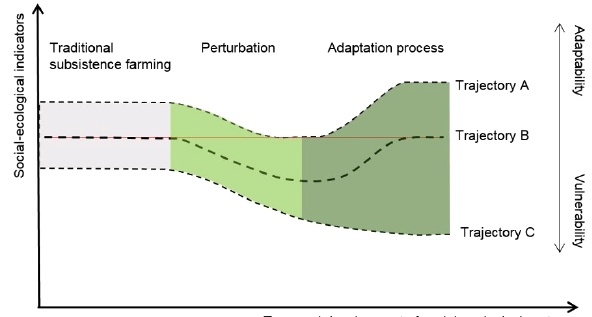
Fig. 5 . Potential system trajectories that may also apply to the landscape of Banaue. In trajectory A, the system recovers from the perturbation and is able to take advantage of new opportunities, therefore demonstrating adaptability. Trajectory B shows a robust system that conserves the same level of ecosystem services and benefits after recovery from the perturbation. Trajectory C shows vulnerability of the system to perturbation and the incapacity of the system to fully recover from the disturbance, but without necessarily experiencing a shift of the fundamental social-ecological system structures, processes, and